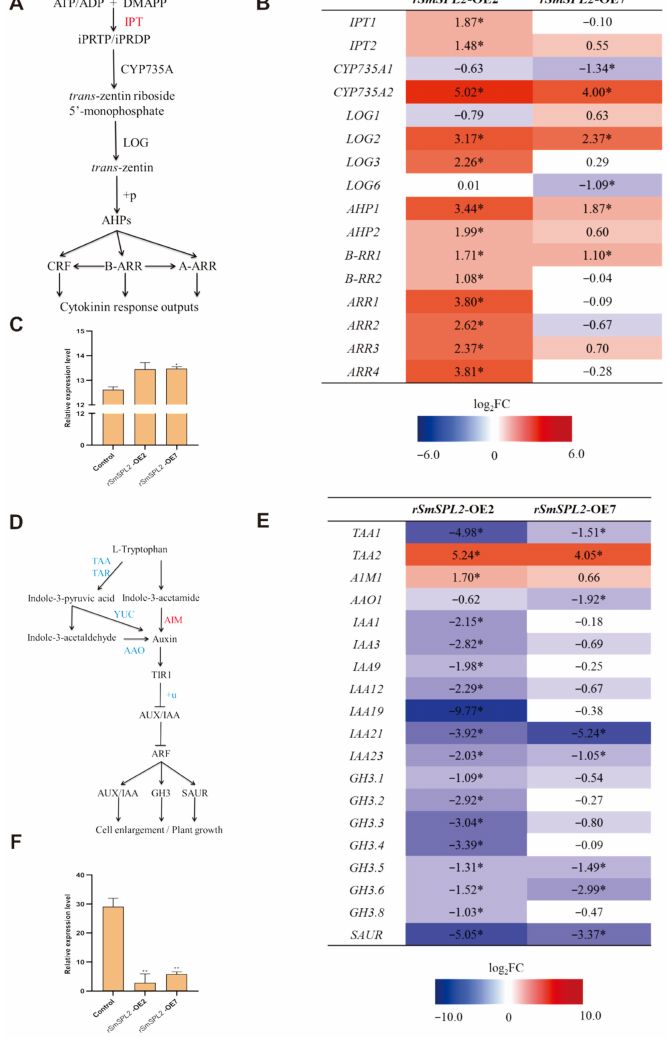
Figure 4. Changes in transcriptional levels of genes for cytokinin and auxin biosynthesis and signal transduction. ( A ) Proposed biosynthetic and signal transduction pathway for cytokinin. DMAPP, dimethylallyl pyrophosphate; IPT, isopentenyl transferases; CYP, cytochrome P450 enzyme; LOG, LONELY GUY; AHPs, histidine phosphotransfer proteins; CRF, cytokinin response factors; B-AAR, type-B response regulators; A-AAR, type-A response regulators. ( B ) DEGs involved in cytokinin biosynthesis and the signal transduction pathway. For each gene, the relative expression ( rSmSPL2 -OE2 vs. control and rSmSPL2 -OE7 vs. control) was expressed in Log 2 FC. Blue boxes (gene expression is down-regulated); Red boxes (gene expression is up-regulated). * indicates differentially expressed genes. ( C ) Concentrations of cytokinin in root extracts from control and transgenic line rSmSPL2 -OE2 and rSmSPL2 -OE7. *, values are significantly different from control at p < 0.05 by Student’s t -test. ( D ) Proposed biosynthetic and signal transduction pathways for auxin. TAA, Tryptophan aminotransferase of Arabidopsis; TAR, Tryptophan aminotransferase related; YUC, YUCCA; AIM, Indole-3-acetamide hydrolase; AAO, Aldehyde oxidase; TIR1, Transport Inhibitor Response 1; AUX/IAA, auxin/indole acetic acid; GH3, Gretchen Hagen 3; SAUR, small auxin-up RNA. ( E ) DEGs involved in auxin biosynthesis and signal transduction pathway. For each gene, the relative expression ( rSmSPL2 -OE2 vs. control and rSmSPL2 -OE7 vs. control) was expressed in Log 2 FC. Blue boxes (gene expression is down-regulated); Red boxes (gene expression is up-regulated). * indicates differentially expressed genes. Gene ID were listed in Table S2. ( F ) Concentrations of auxin in root extracts from control and transgenic line rSmSPL2 -OE2 and rSmSPL2 -OE7. **, values are significantly different from control at p < 0.01 by Student’s t